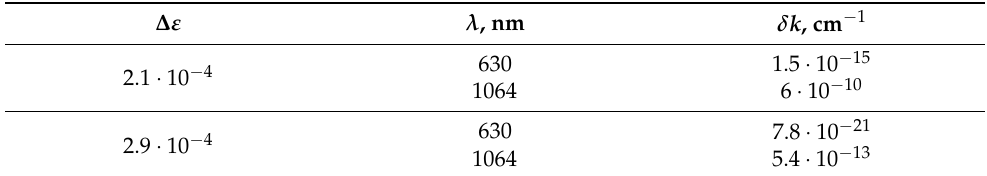
Table 1. The widths of transmission curves δ k for different modulation amplitudes ∆ ε and wave- lengths λ . L = 0.75 cm, d = 1 m.